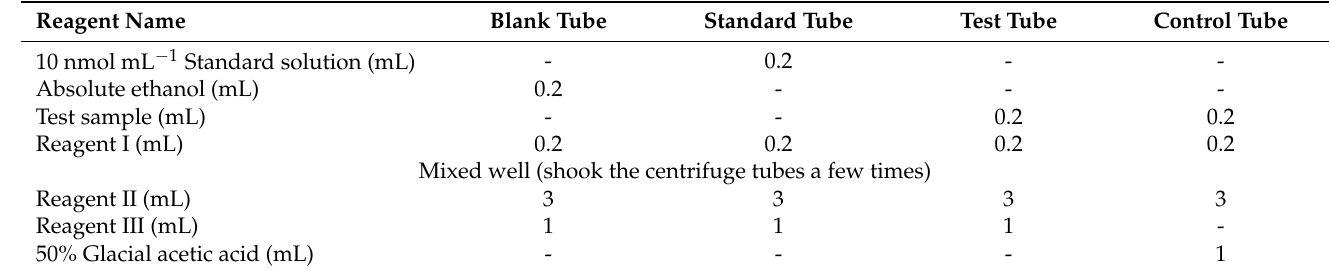
Table 1. Operation method.